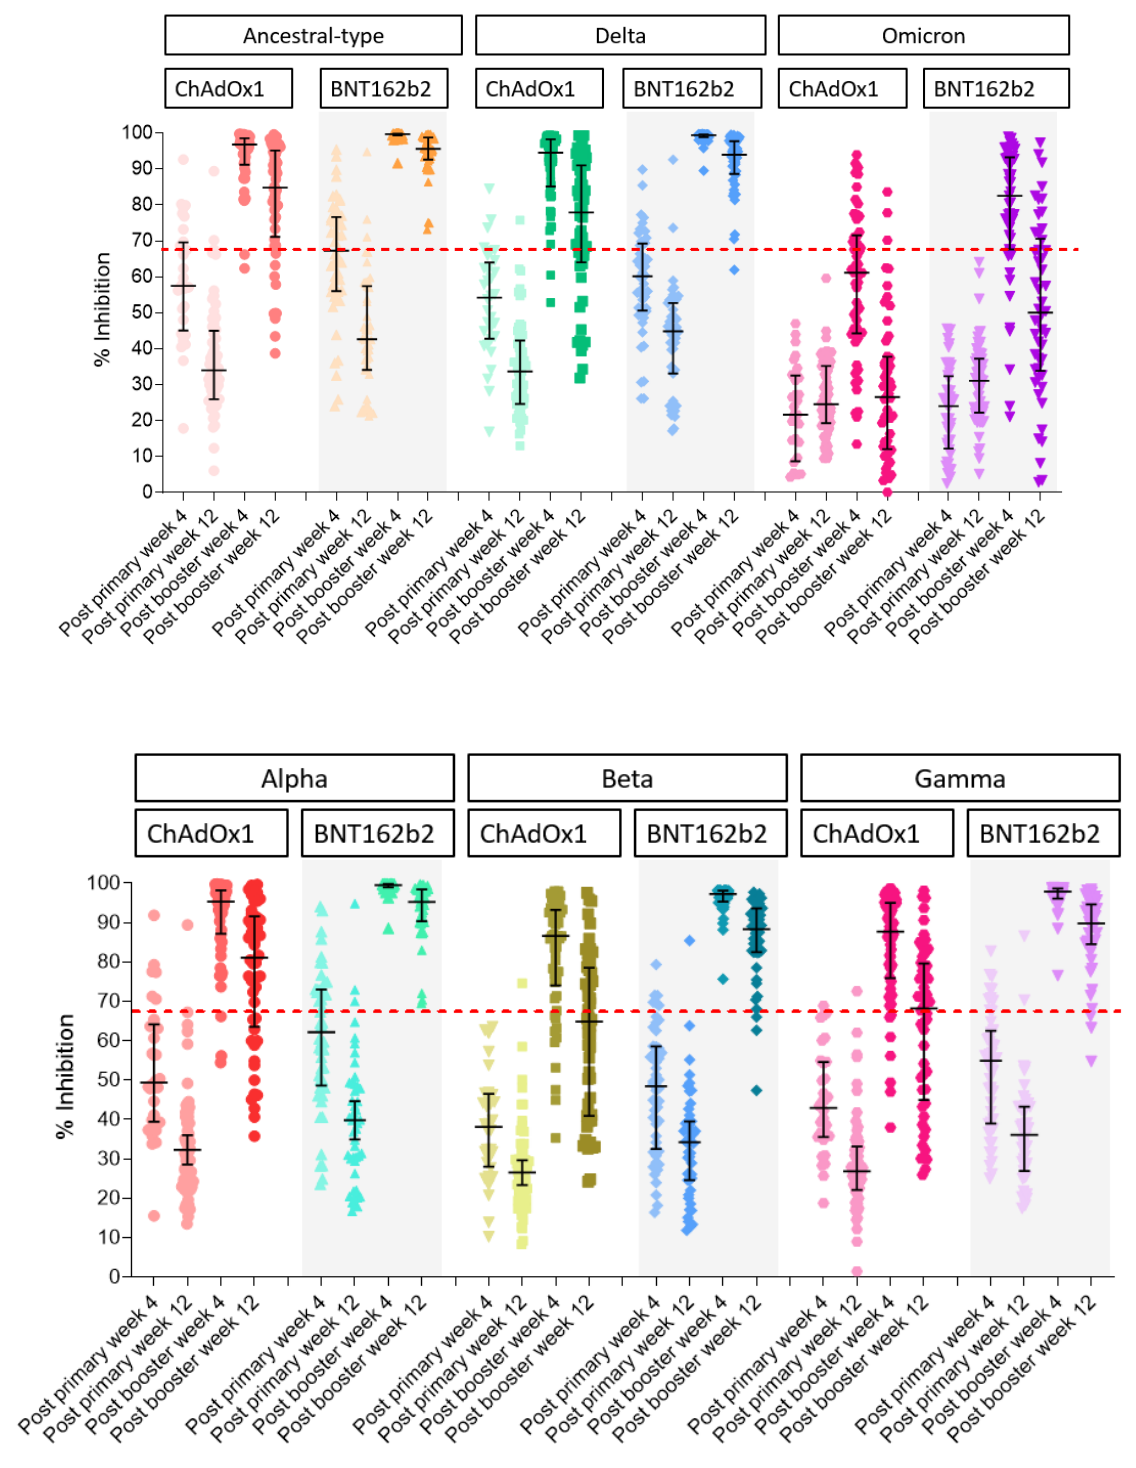
Figure 2. Dynamics of immune response surrogate neutralizing antibody (sVNT) to ancestral type, Delta, Omicron, Alpha, Beta, and Gamma in participants who received primary CoronaVac vaccination and were boosted with BNT162b2 or ChAdOx1 by multiplex sVNT .